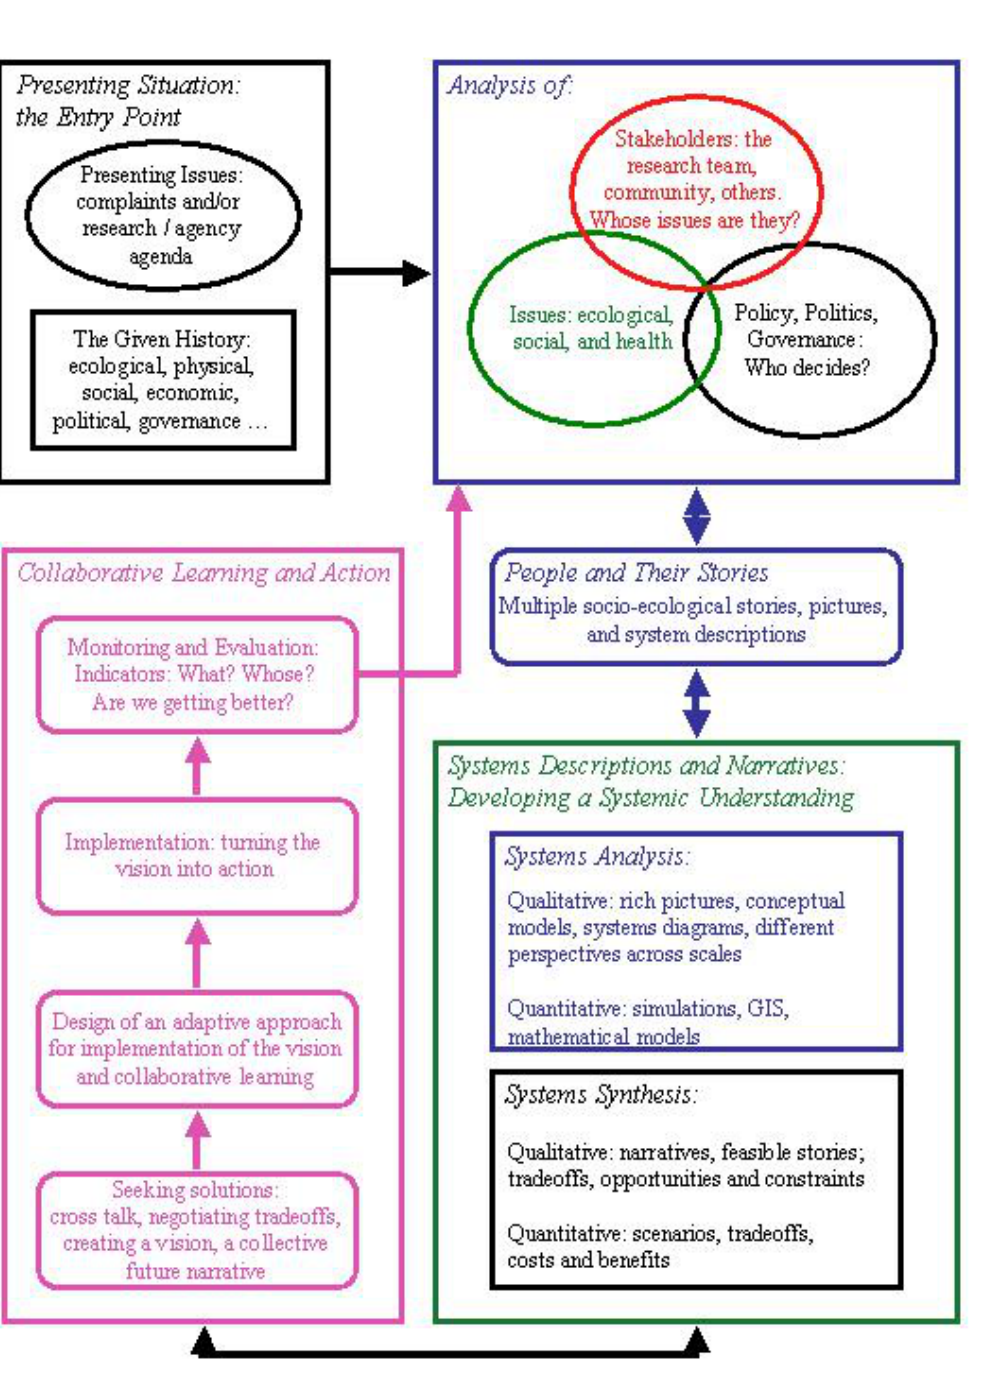
Fig. 3. Adaptive Methodology for Ecosystem Sustainability and Health, integrating researchers as